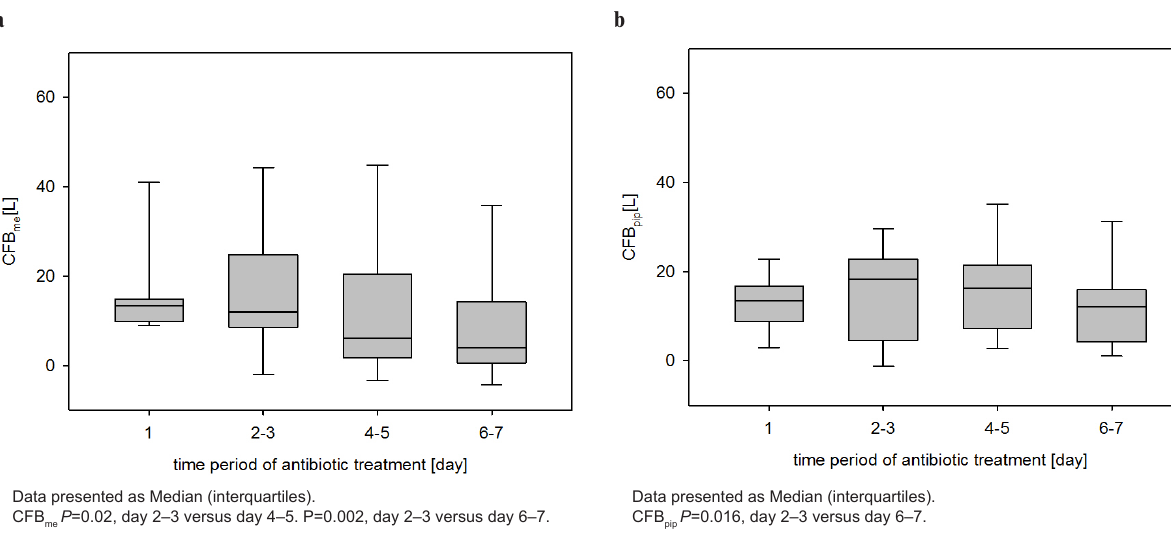
) and b/ polytraumatized patients Fig. 1. Cumulative fluid balance (CFB) in a/ septic patients treated with meropenem (CFB me treated with piperacillin/tazobactam (CFB ) during 7 days. pip CFB [L] measured as the difference between fluid input and loss results from increased vascular permeability and fluid loading. The extreme values in CFB were noticed in the patient with the initial Cl = 9 mL/min. The median CFB and CFB reached me cr me pip a maximum on day 2–3 and slowly declined afterwards if fluid therapy was stopped and enhanced vascular permeability returned to a normal state.